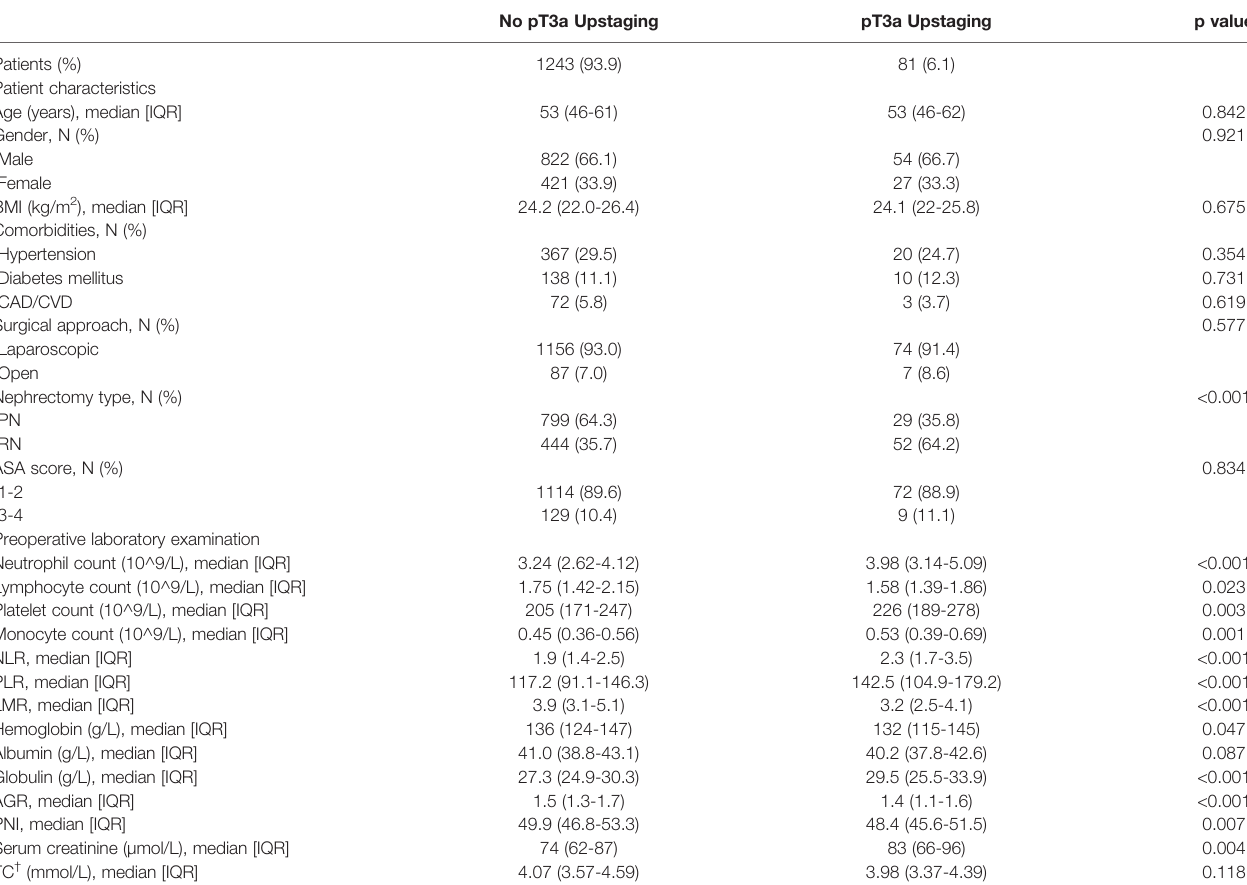
TABLE 1 | Baseline demographic and clinical characteristics of study